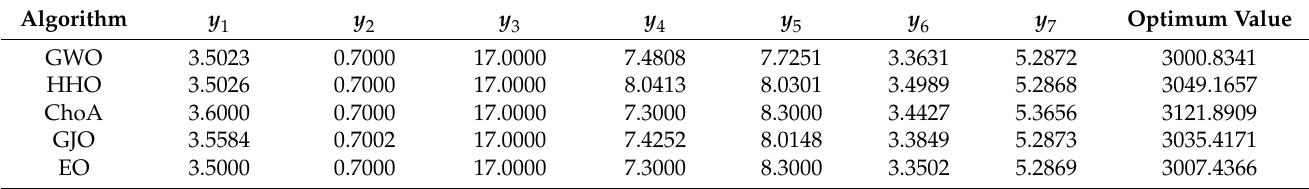
Table 7. Comparison results of speed reducer design problem. The best results of the experiments are shown in bold.